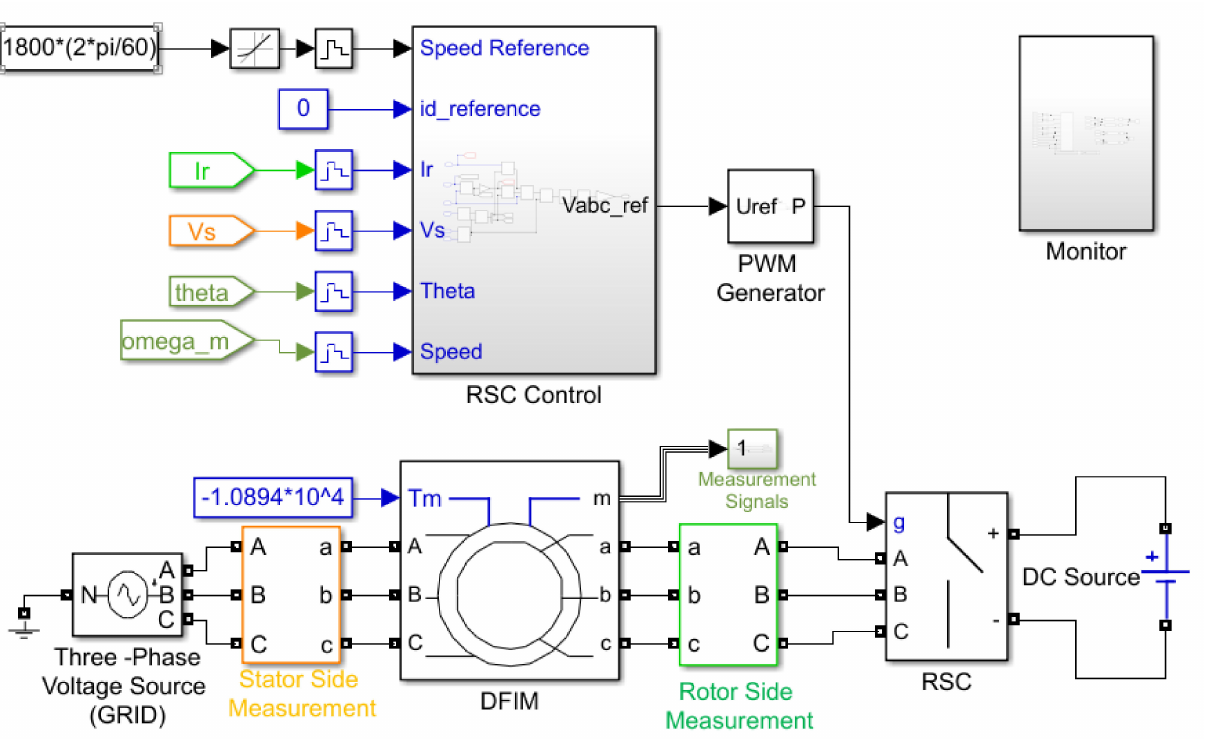
Figure 2. Simulation model of a 2 MW DFIG with RSC Control.